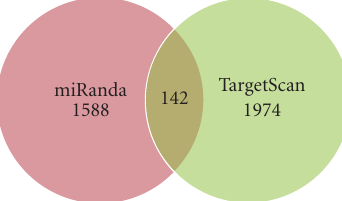
Figure 6: Intersection of miRanda and TargetScan.